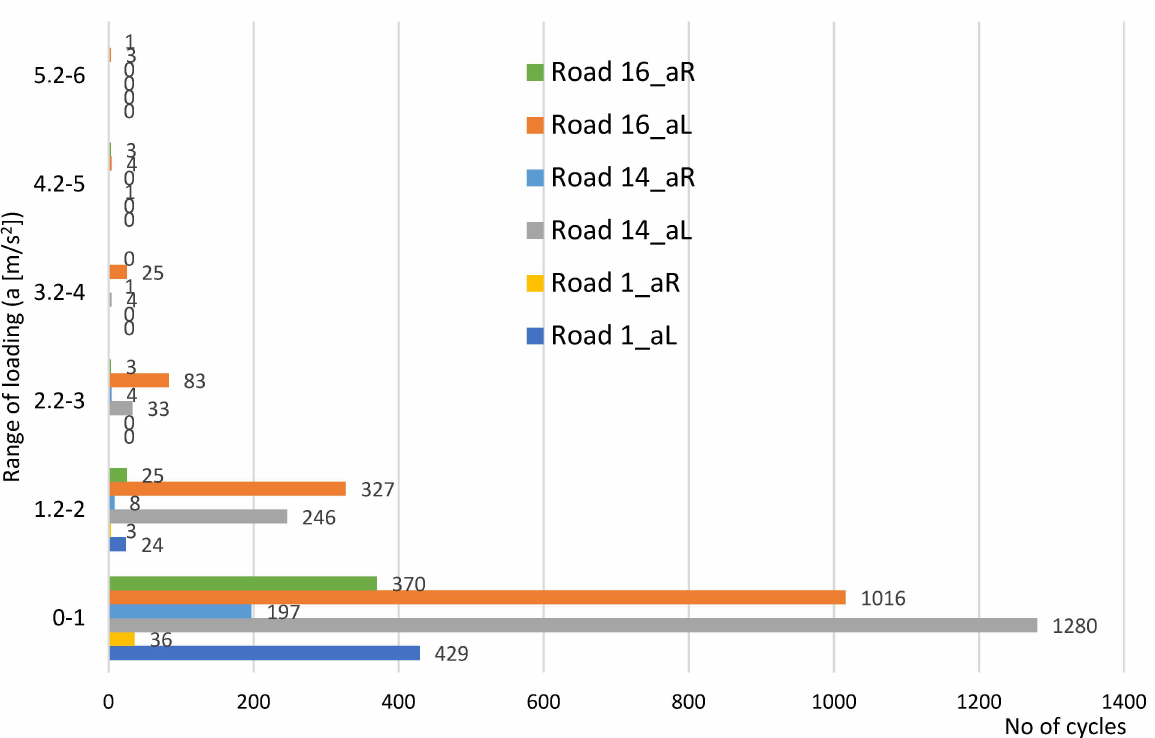
Figure 9. Examples of cabin acceleration cycles on the left (aL) and right (aR) sides of the